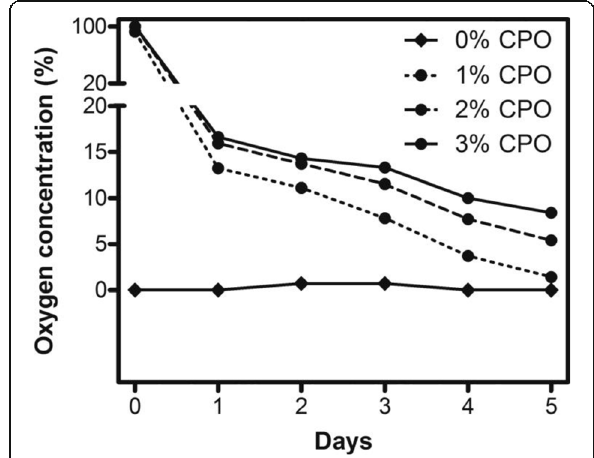
Fig. 9 Comparison of oxygen release capacity of various groups of hydrogels under hypoxia conditions. Reproduced with